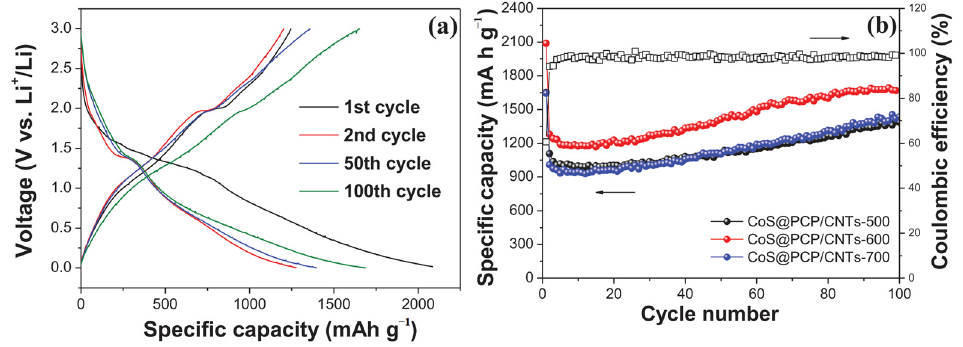
Figure 15. ( a ) Galvanostatic charge-discharge voltage profiles of 3D hollow CoS@PCP/CNTs-600 polyhedral at the current density of 0.2 A g − 1 ; ( b ) Cycling performances of CoS@PCP/CNTs-500, CoS@PCP/CNTs-600, and CoS@PCP/CNTs-700 and Coulombic efficiency of CoS@PCP/CNTs-600 at